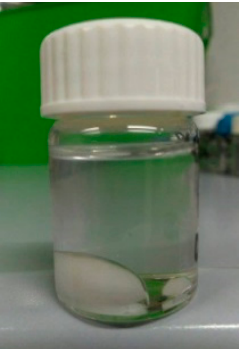
Figure 1. Third phase in the solvent phase after the removal of the aqueous phase for formic acid with 25:25 TOA:1-octanol by weight, diluted in n -undecane; c formic, initial = 0.8 mol/L; T= 25 °C; ambient pressure.